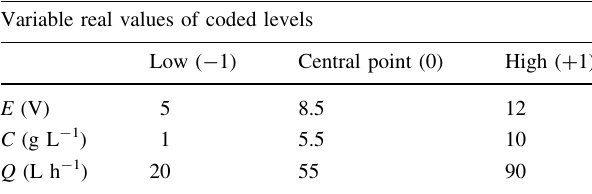
Table 3 Experimental range and levels of independent variables Variable real values of coded